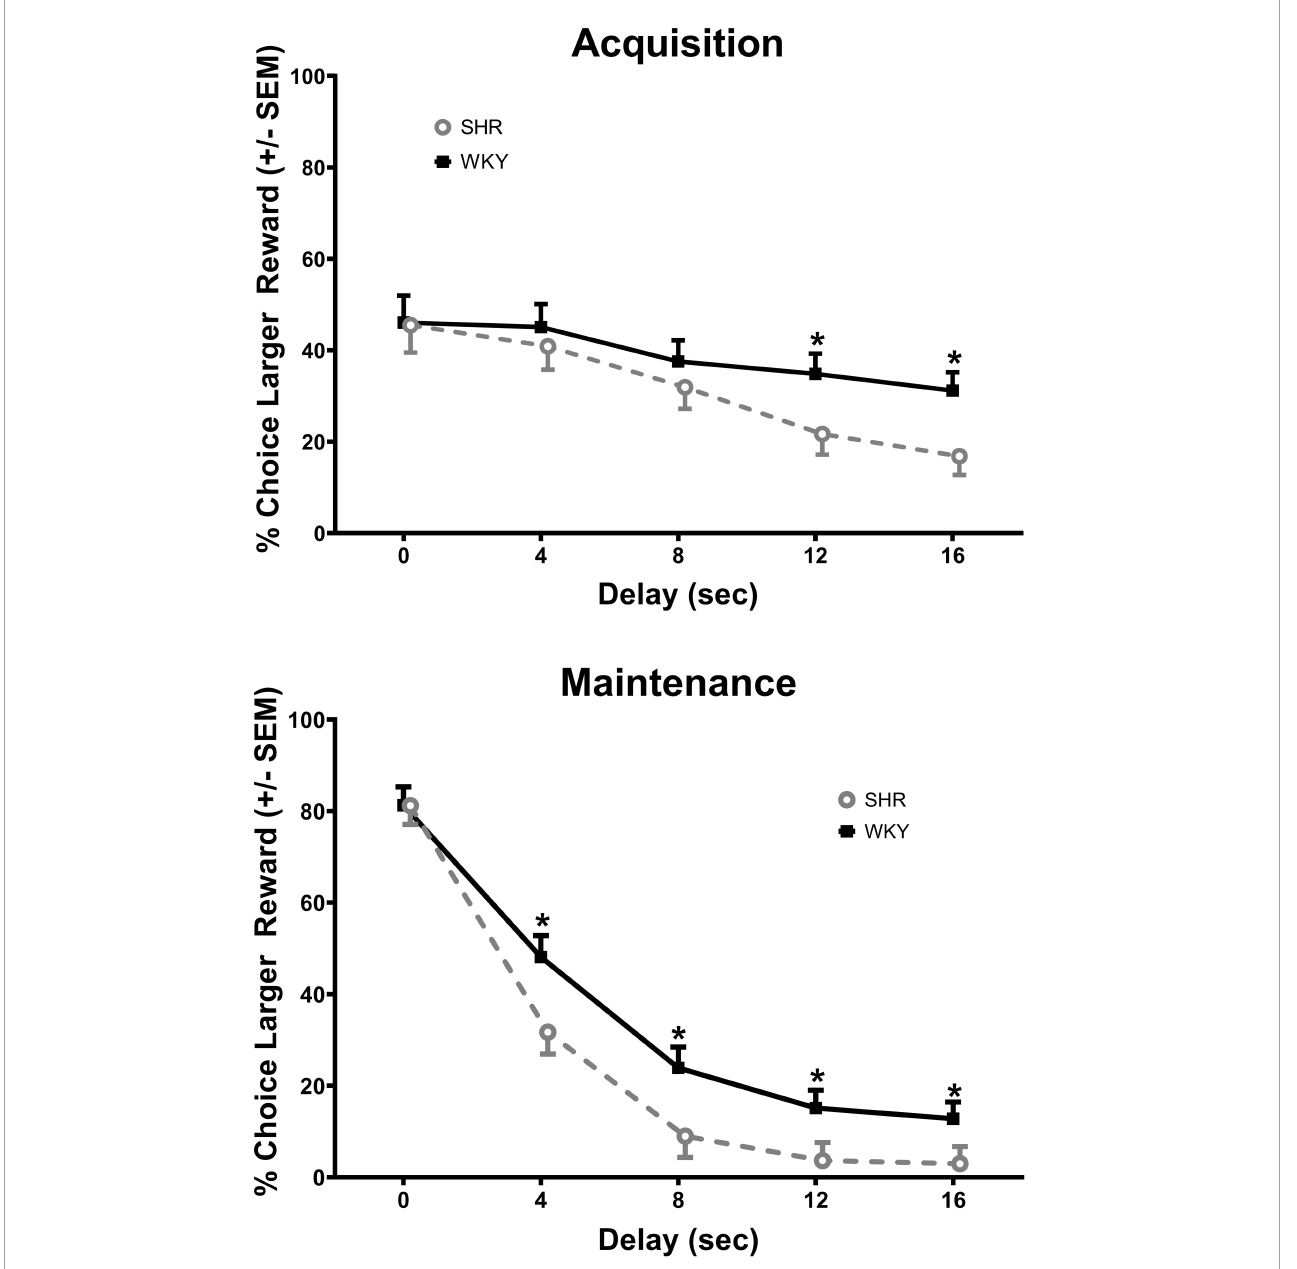
FIGURE1 Percent choice for the larger reward during acquisition (top) and maintenance responding (bottom) for the spontaneously hypertensive rat (SHR) and WKY rats with equal trial lengths. The SHRs discounted the larger reward significantly more than the WKY rats at the longest two delays of acquisition and at all delays during maintenance, * p <